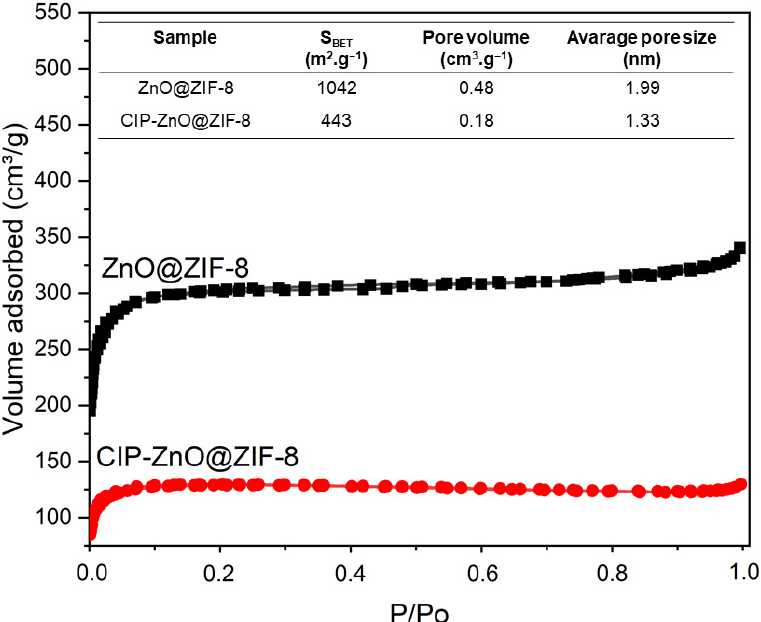
Figure 5. N 2 adsorption–desorption isotherms and BET surface areas (inset table) of ZnO@ZIF-8 and CIP-ZnO@ZIF-8.